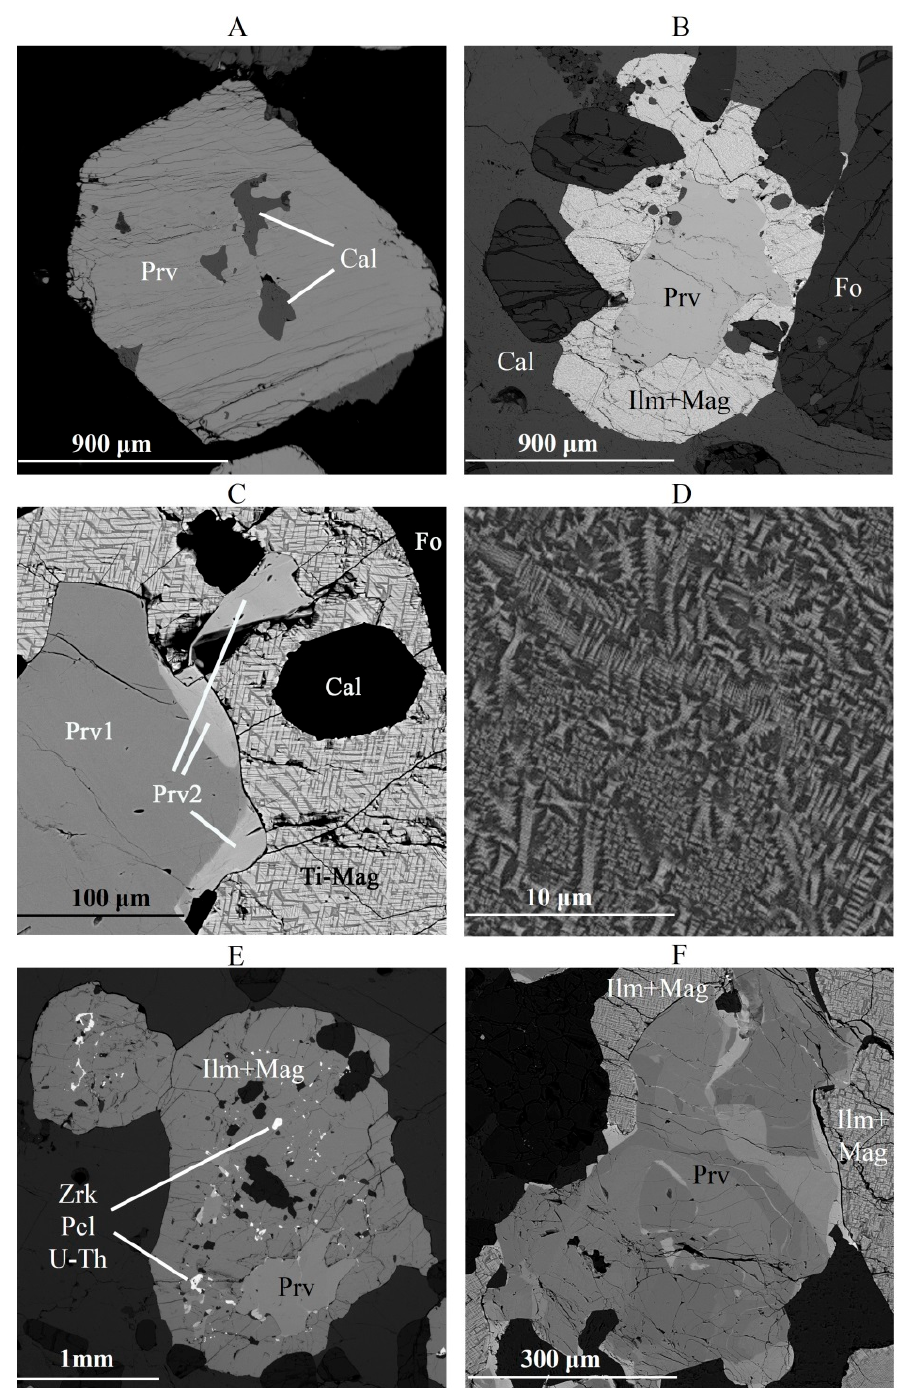
Figure 9. BSE images of perovskite from Fo-Spl calc–silicate rocks coexisting with skarns (site 4): ( A ) Compositionally homogeneous octahedral perovskite crystal with calcite inclusions; ( B ) irregularly shaped perovskite grain coated with epitaxially intergrown magnetite and Mg ilmenite; ( C ) a fragment of panel (B), with two generations of perovskite; ( D ) enlarged fragment of magnetite(bright)–ilmenite(dark) coat around a perovskite grain; ( E ) several perovskite grains in a magnetite–ilmenite coat with small inclusions of uraninite–torianite, nöggerathite–(Ce), and Ti-U-Th-Zr-Nb phases; ( F ) irregularly shaped and compositionally inhomogeneous perovskite grain in a magnetite–Mg–ilmenite coat. Abbreviations: zirkelite (Zrk), pyrochlore (Pcl), Ti-U-Th-Zr-Nb phases (U-Th), other minerals after [20].